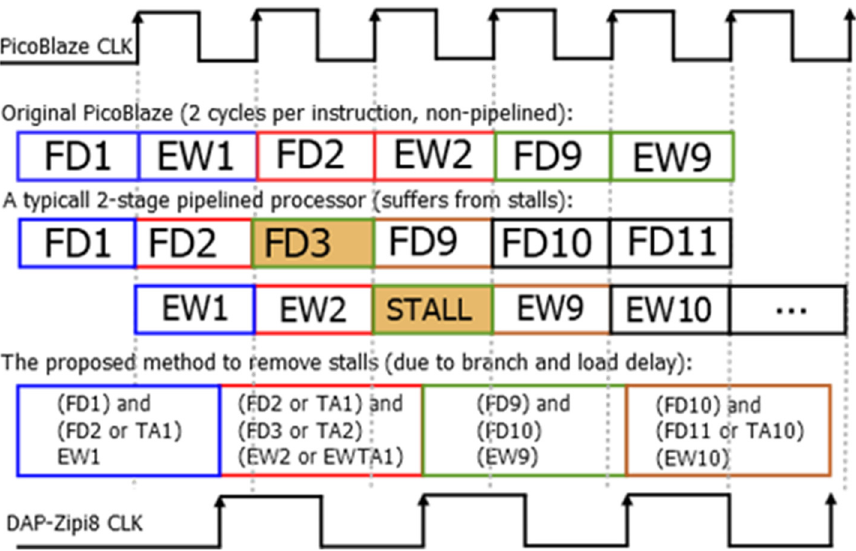
Figure 7. Original PicoBlaze versus a two-stage pipeline versus the proposed method (assuming instruction 2 is a conditional branch to arbitrary location 9 and it is